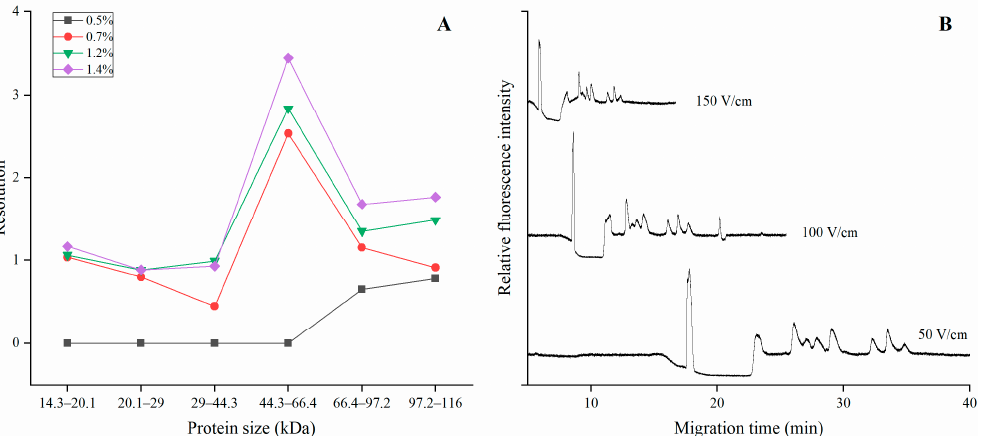
Figure 3. ( A ) The resolution for the adjacent proteins at mixed HEC (1,300,000/250,000) solution with concentrations varying from 0.5% ( m / v ) to 1.4% ( m / v ). ( B ) The electropherogram of proteins when they were separated at electric field strength varied from 50 V/cm to 150 V/cm. The ratio of the two HEC polymers was 5/5, and other electrophoretic conditions were the same as in Figure 1.